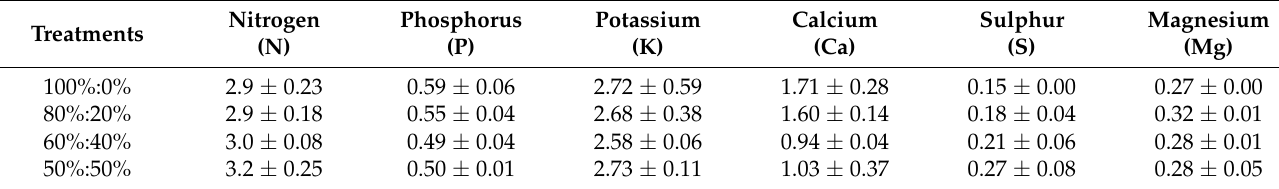
Table 3. Macronutrient content (shown in %) in leaf tissue sample of strawberry plants of four treatments. The leaf sample was taken from the youngest mature leaf twice during the experiment. Ten plants of each treatment were sampled at each sampling timepoint. Data are presented as the mean ± standard deviation ( n = 2). No statistical differences were observed between treatments.